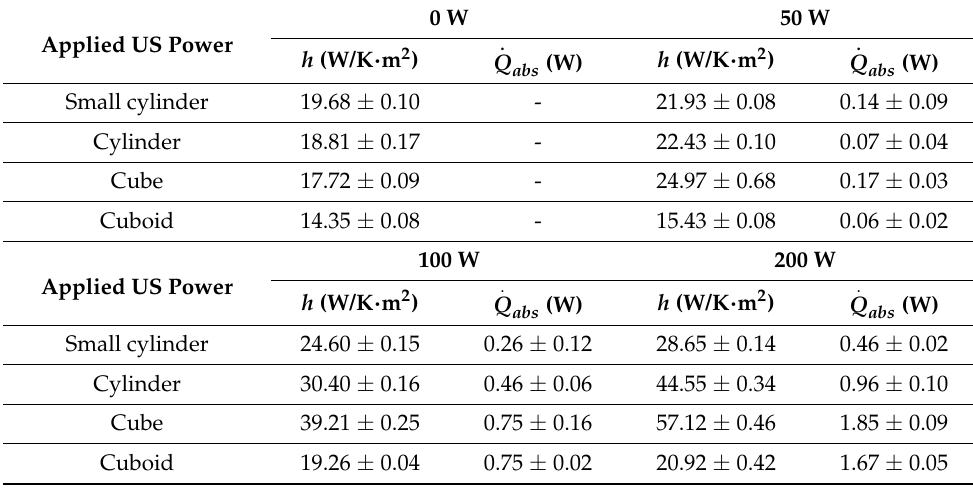
Table 3. Results of heating in temperature 40 ◦ C.